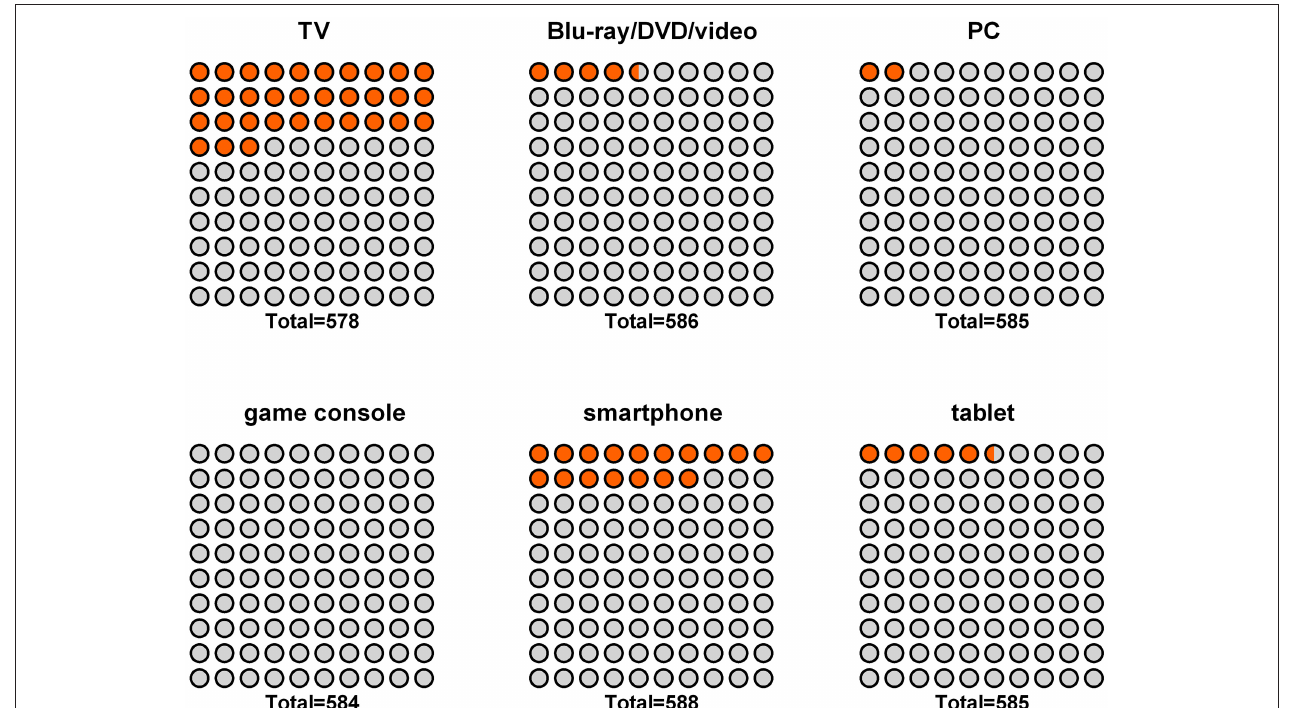
FIGURE 2 | Percentage of infants exposed to different types of media during the first year of life.